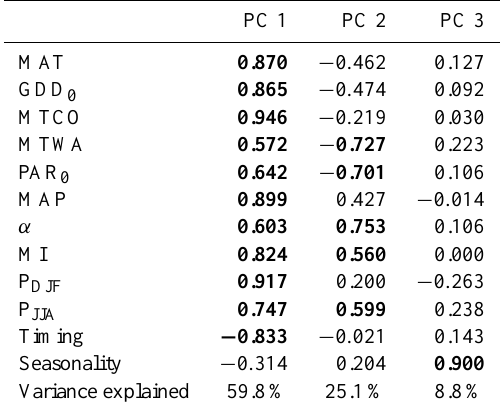
Table 1. Principal components of climate data based on the 80 sam- pling sites. Each component (axis) represents a linear combination of variables. Loadings for variables represent the contribution of each variable to the axis. Values are shown in bold when their mag- nitude